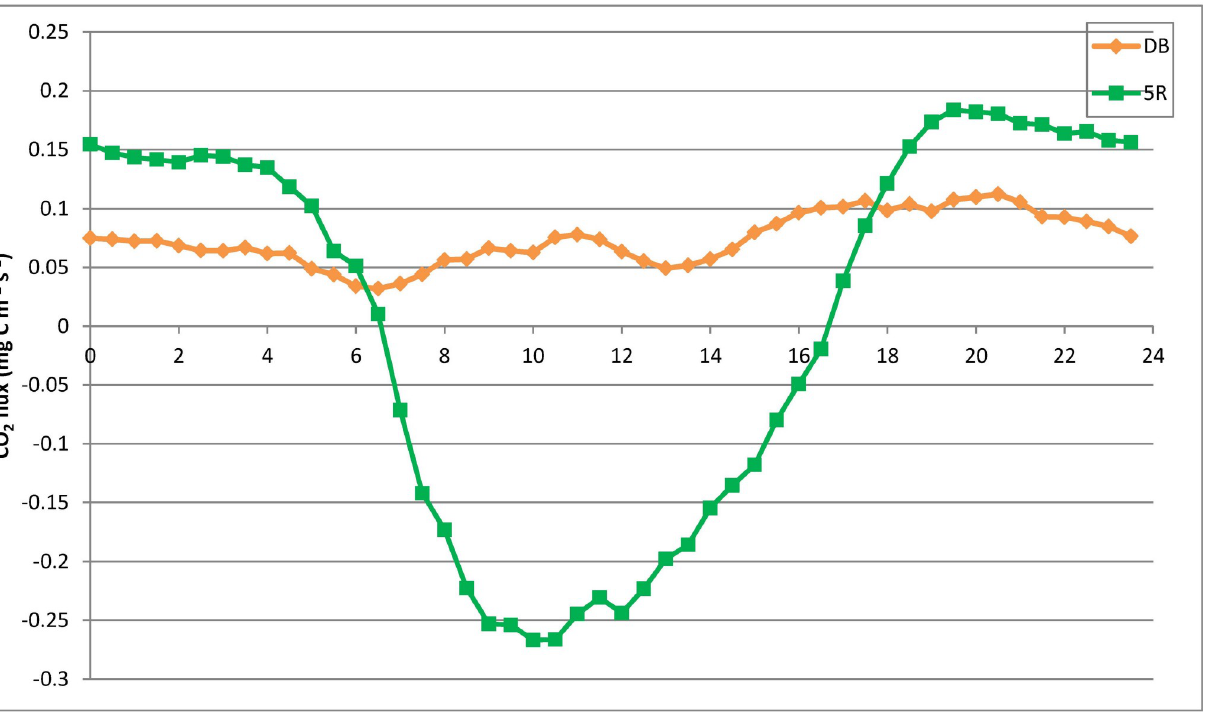
Fig 3. Diurnal patterns of the CO 2 flux at 5R and DB.